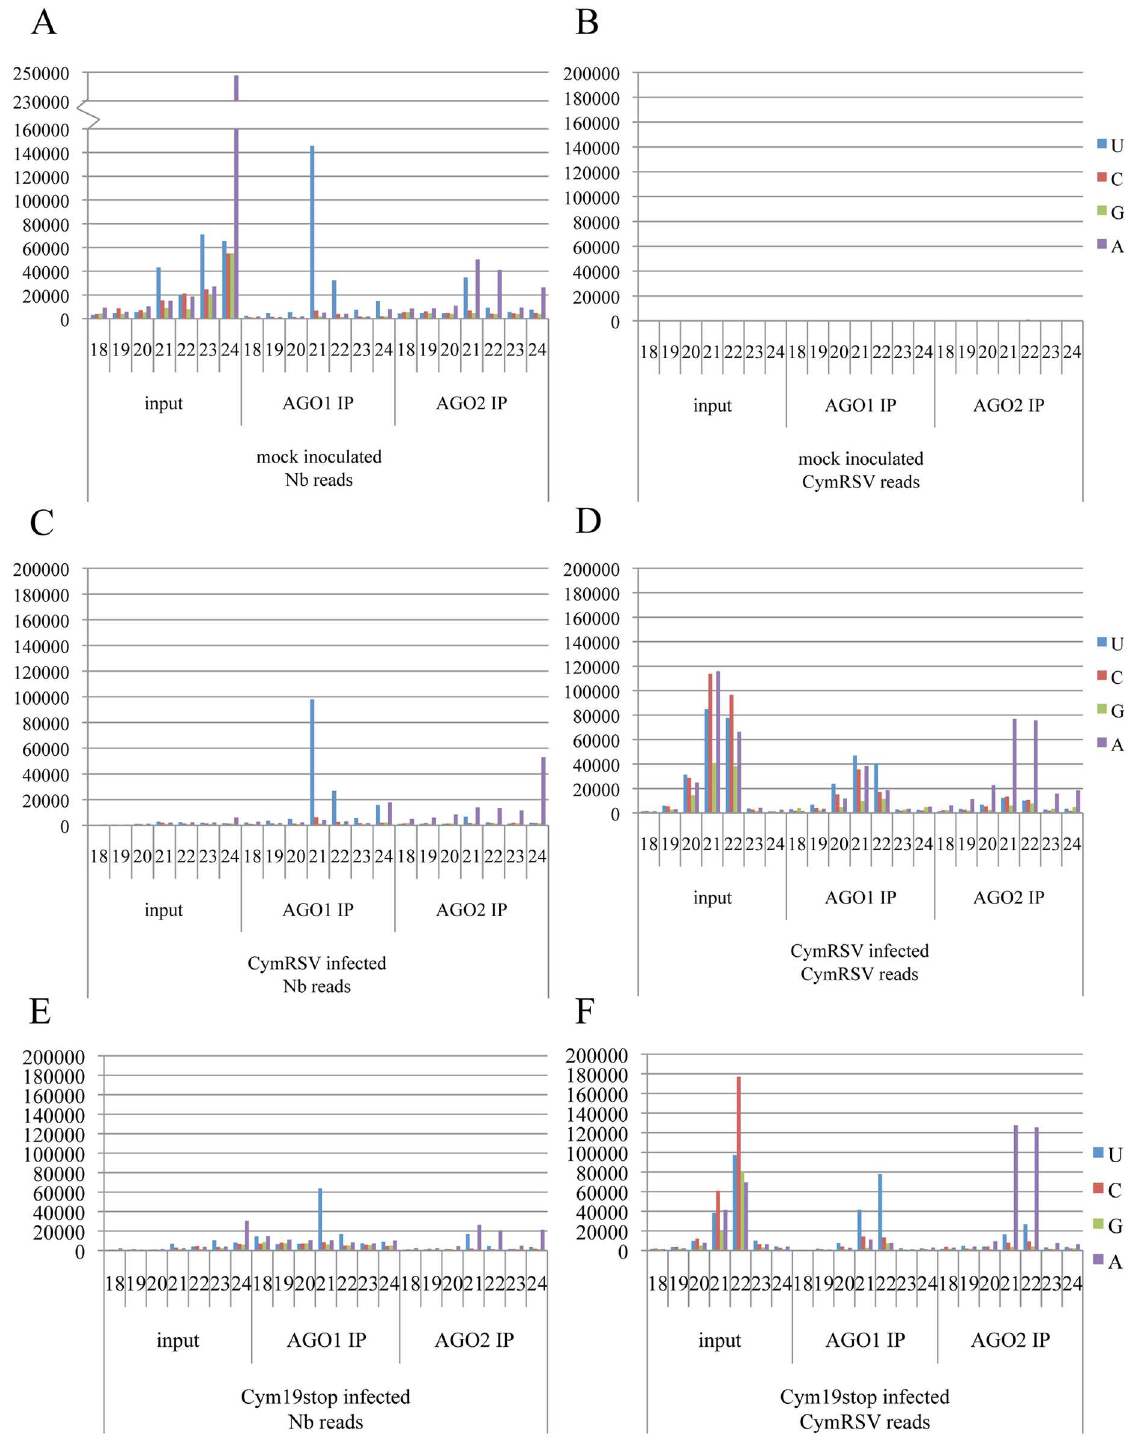
Fig 6. Deep sequencing analysis of AGO1- and AGO2-bound sRNAs. N . benthamiana specific reads from mock-inoculated (A), CymRSV- (C) and Cym19stop-infected wild-typeplants (E). The vsiRNA reads of the same samples are presentedin (B), (D) and (F) respectively. 5’ nucleotides of vsiRNAs are indicatedby color code on the right. Size classes (nucleotide) of sRNAs are indicated by numbers. Read counts were normalized to 10 6 total reads. Note the different scale in panel